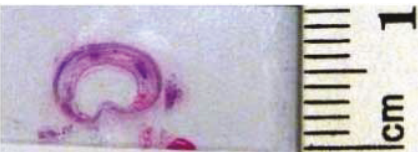
Figure 6: Photograph of the macroscopic section of the tracheal defect to analyze the morphology of the tracheal